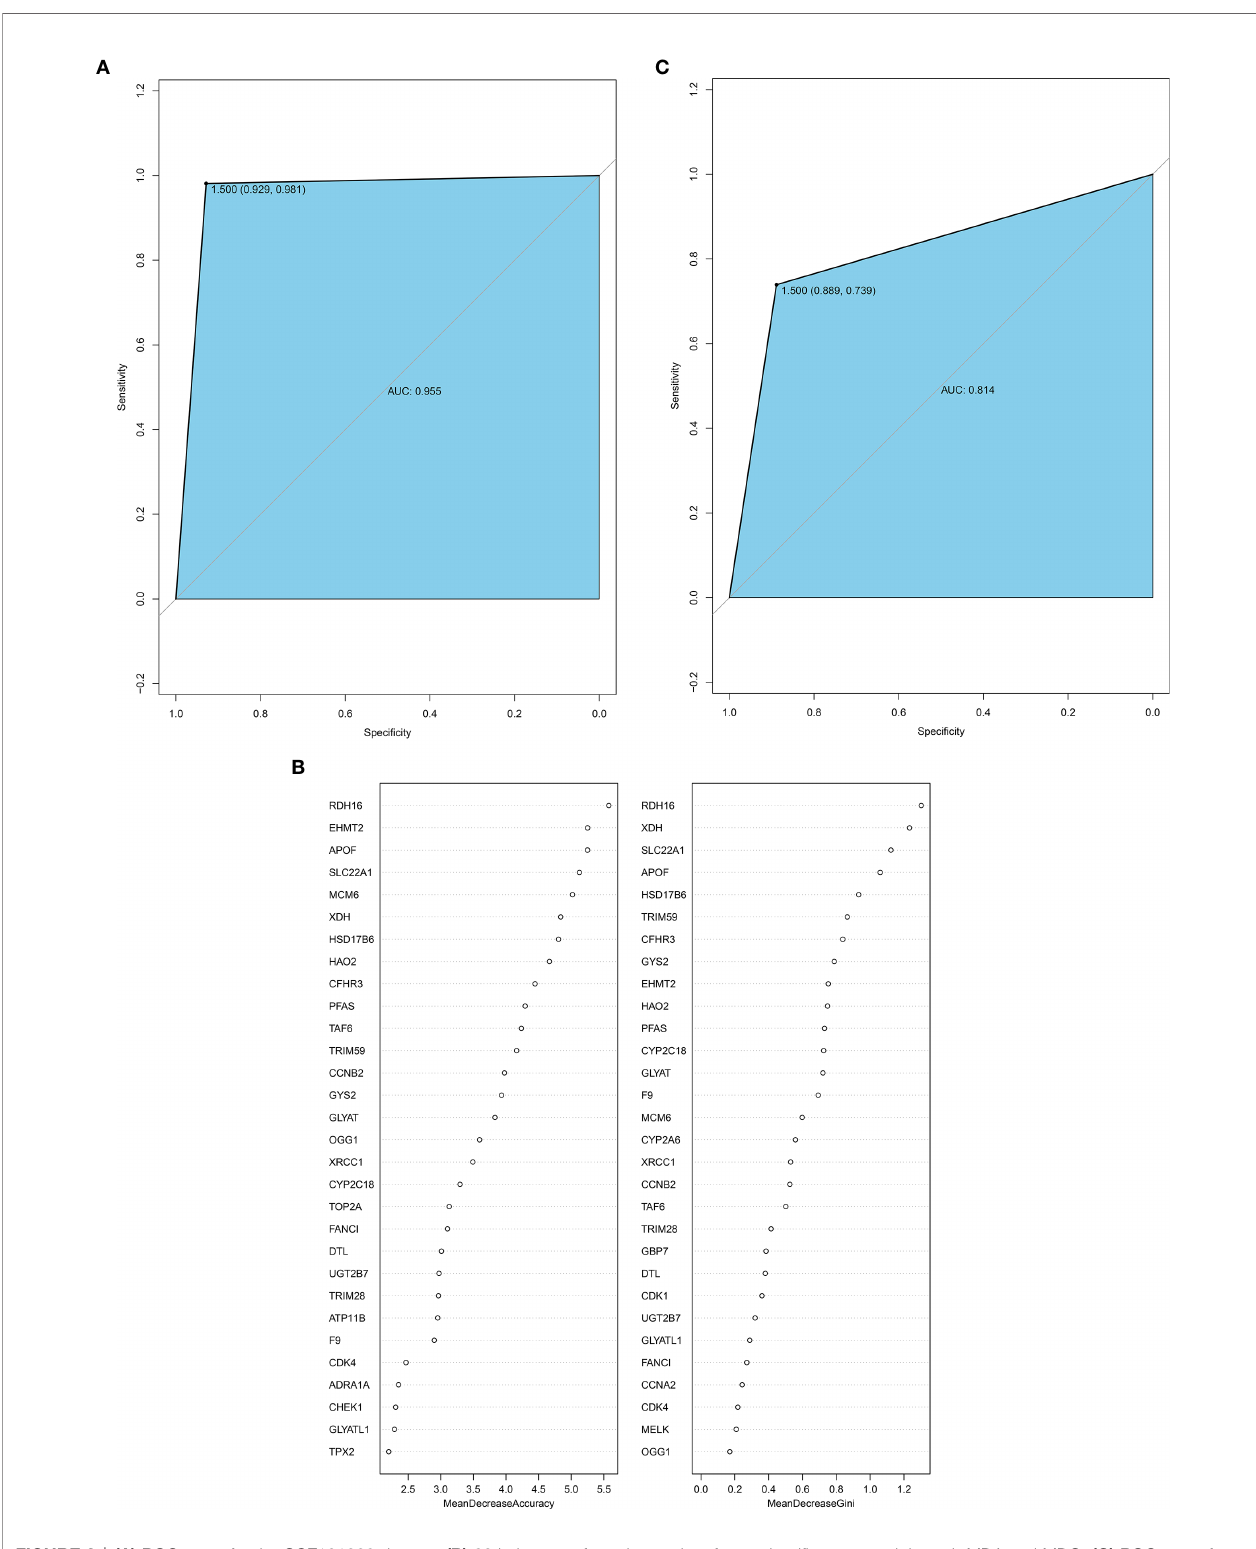
FIGURE 8 | (A) ROC curve for the GSE131329 dataset; (B) 30 hub genes from the random forest classi fi er extracted through MDA and MDG; (C) ROC curve for the GSE81928 dataset. AUC, area under the curve; ROC, receiver operating characteristic; MDA, mean decrease accuracy; MDG, mean decrease